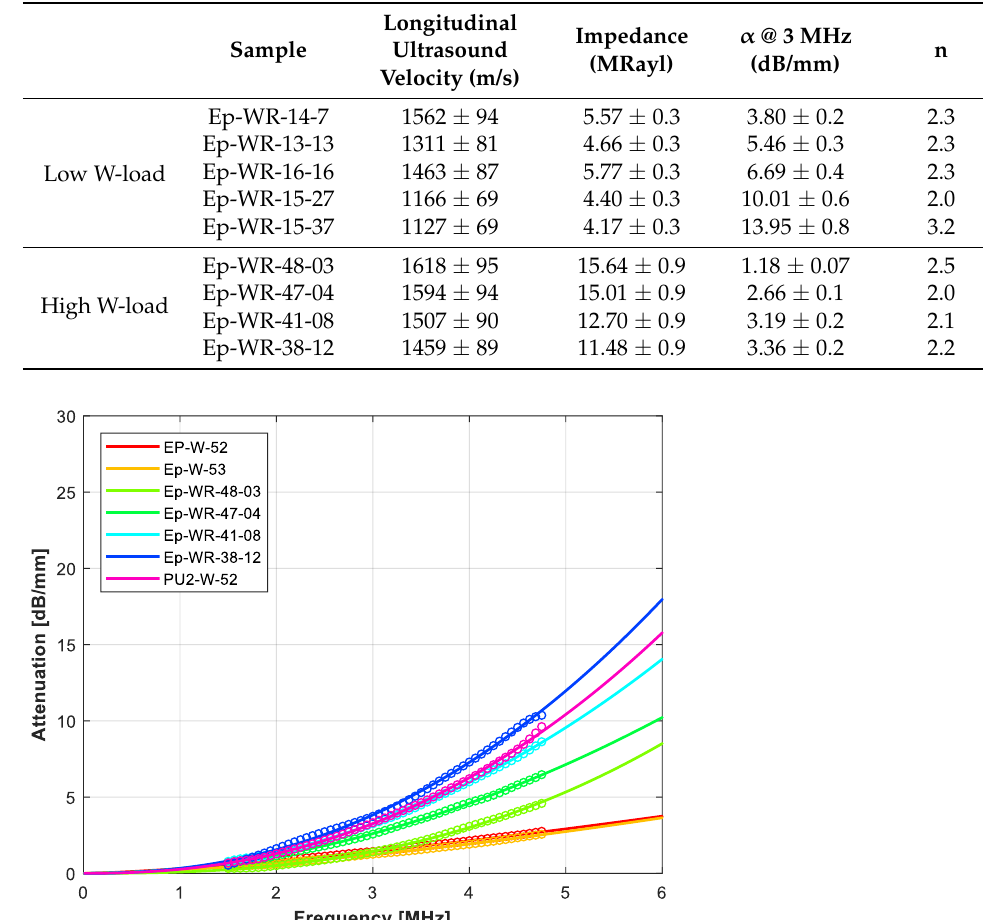
Figure 8. Attenuation ( up ) and Impedance ( bottom ) vs rubber volume fraction. Gray: tungsten volume fraction: 38 – 48%. Black: tungsten volume fraction 14 – 15%. Circles: Experimental meas- urements; Solid line: HS model, lower bound; Starts: HS model, upper bound; +: CPA model.